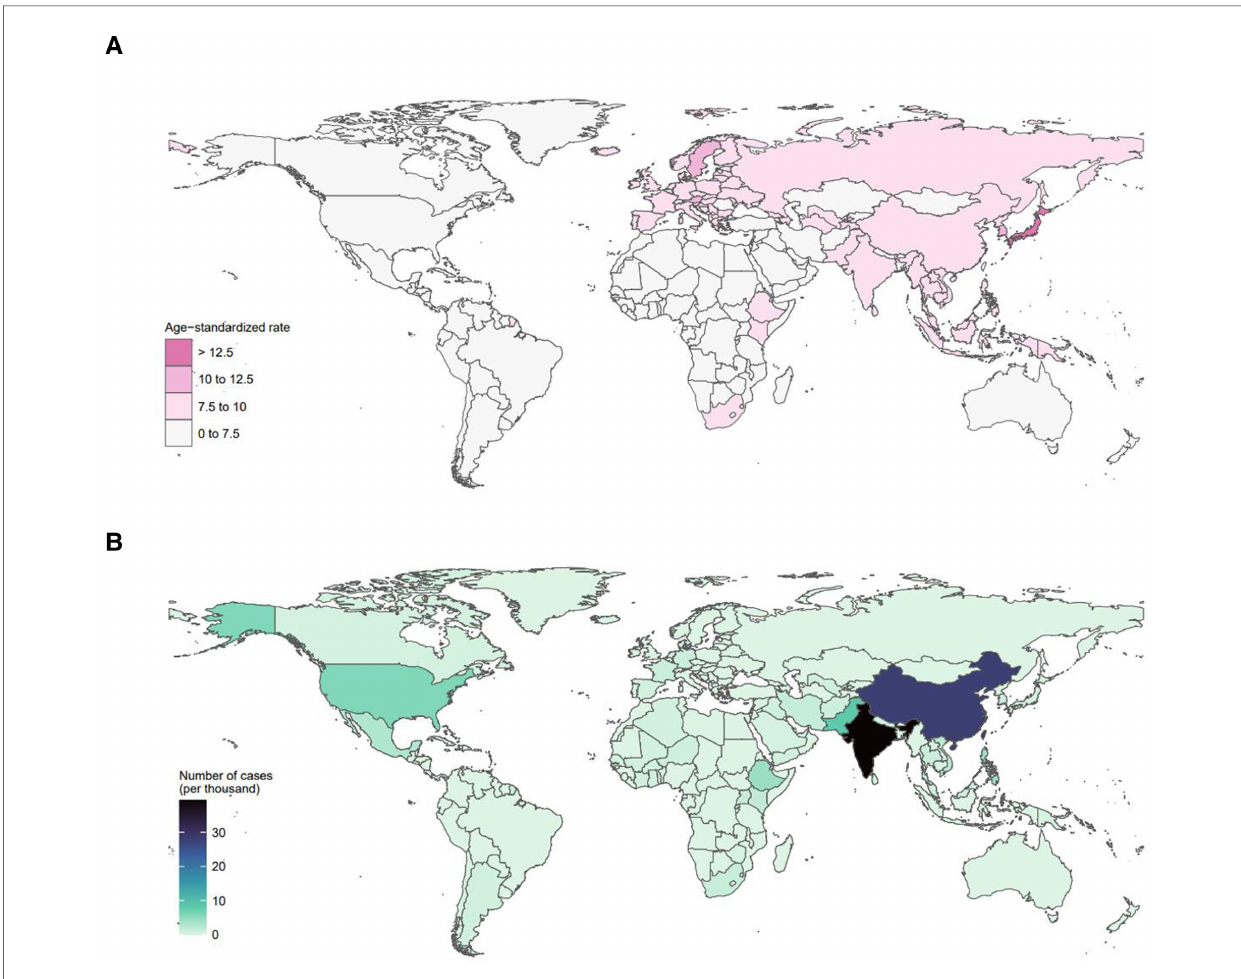
FIGURE 4 Global distribution map of childhood myocarditis and cardiomyopathy in 2019. ( A ) Global age-standardized incidence distribution map of childhood myocarditis and cardiomyopathy. In 2019, Japan had the highest age-standardized incidence of myocarditis and cardiomyopathy in children, followed by Sweden. ( B ) Global distribution map of the number of cases of myocarditis and cardiomyopathy in children in 2019. In 2019, India had the highest number of cases of myocarditis and cardiomyopathy in children, followed by